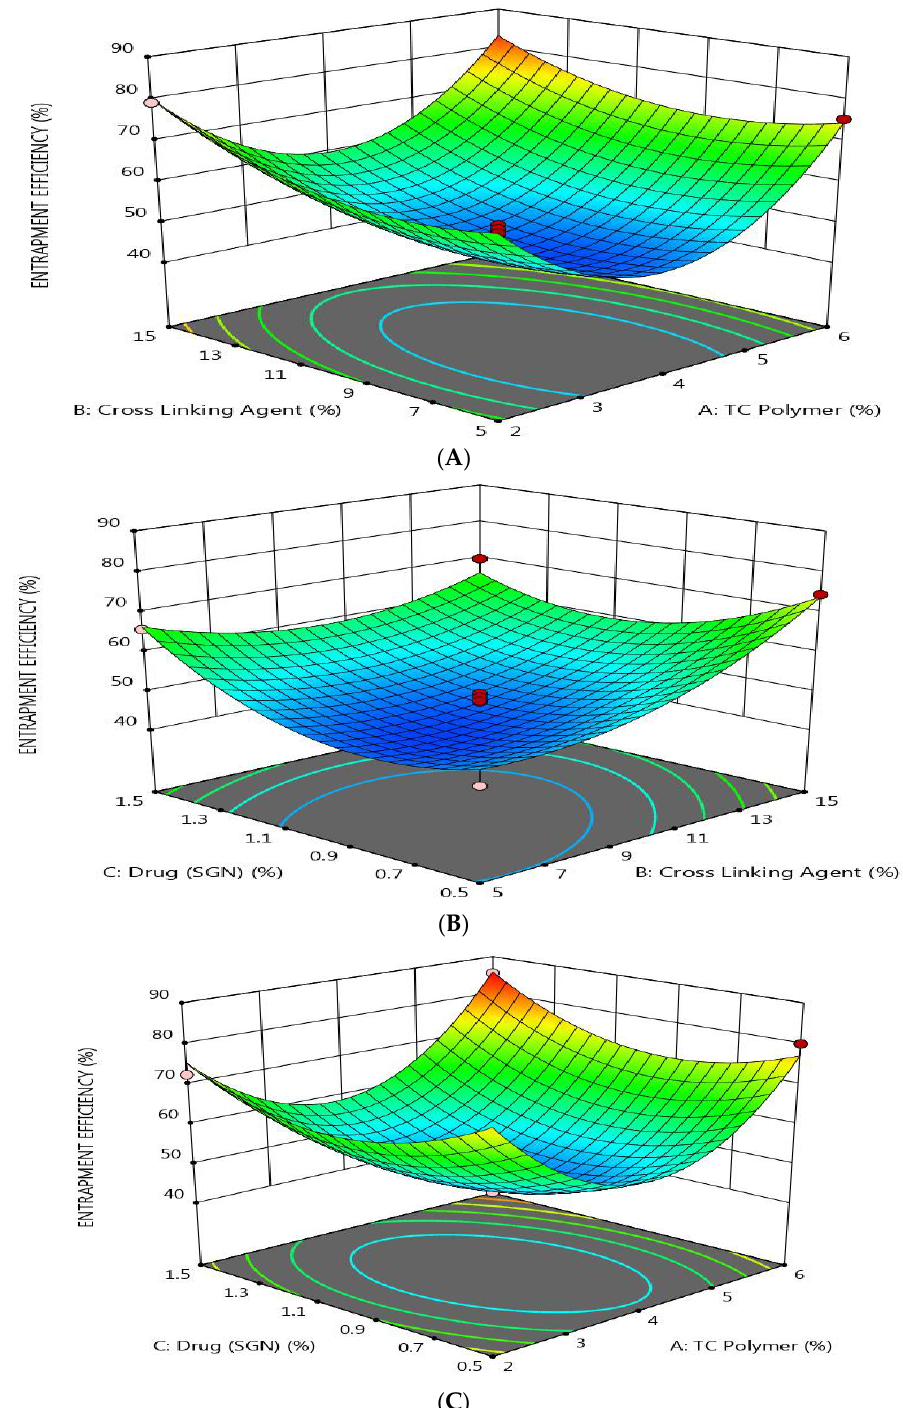
Figure 2. Response surface methodology for the effect of the formulation factors (X 1 , X 2 , and X 3 ) on the entrapment efficiency of SGN–TC nanoparticles. ( A ) Effect of polymer and crosslinking agent concentration on entrapment efficiency %, ( B ) Effect of crosslinking agent and drug concentration on entrapment efficiency %, ( C ) Effect of polymer and drug concentration on entrapment efficiency %.